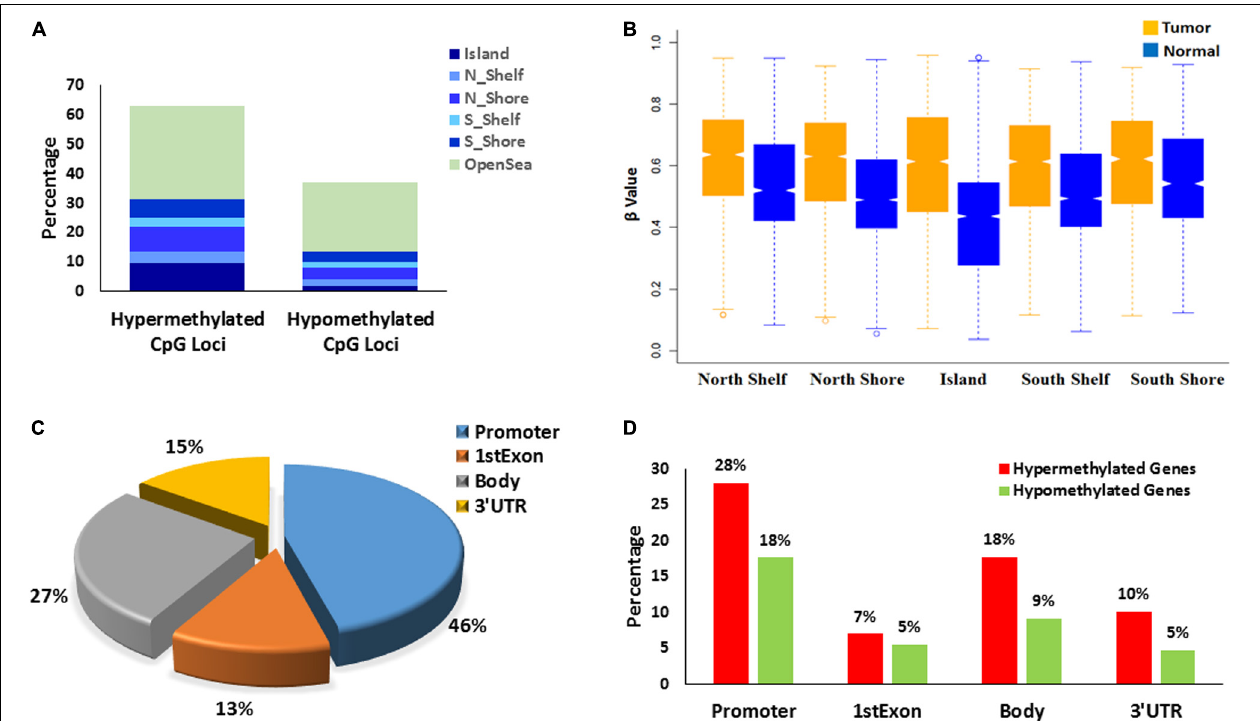
FIGURE 1 | Characterizations of differentially methylated CpG probes/positions: DMPs ( N = 25,494) and differentially methylated regions/genes: DMRs ( N = 5,058). (A) Distribution of the hyper-methylated and hypo-methylated DMPs across different CGI regions and open sea. (B) DMPs mapped to different CGI regions ( N = 11,422) depicts Islands gains maximal methylation in tumor tissues that gradually reduces to Shore. (C) Epigenomic localization of DMRs in different genomic regions – promoter, 1st exon, gene body and 3 (cid:48) UTR. (D) Distribution of hyper-methylated and hypo-methylated DMRs across different genomic